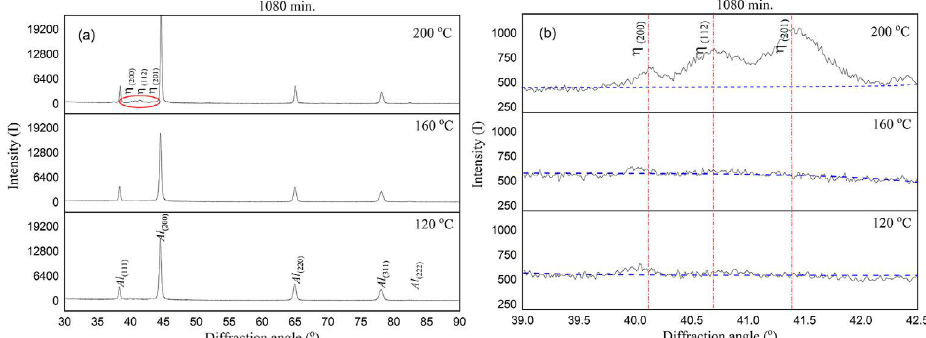
Figure 6. XRD results from samples aged for 1080 minutes at different aging temperatures, a) Peaks obtained between 30- 90º scanning angles from specimens aged for 1080 minutes, b) Zoomed image (39- 42.5 scanning angles)